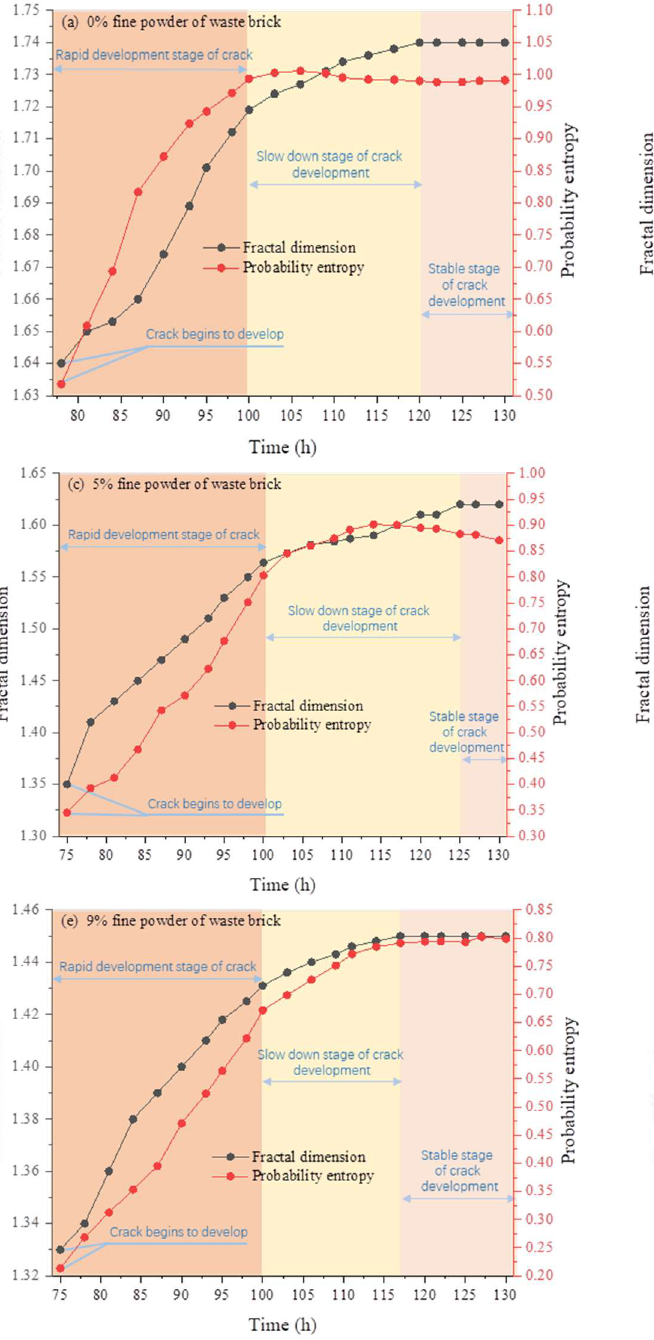
Figure 4. ( a – e ) Changing of fractal dimension and probability entropy of crack development over time. ( f ): Changing of fractal dimensions of soil samples with adding different contents of recycled waste brick micro-powder over time.